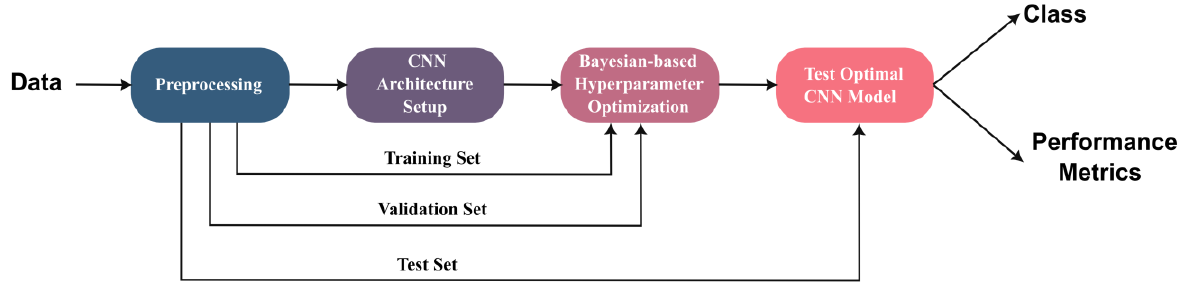
Figure 1. Framework of the proposed study.